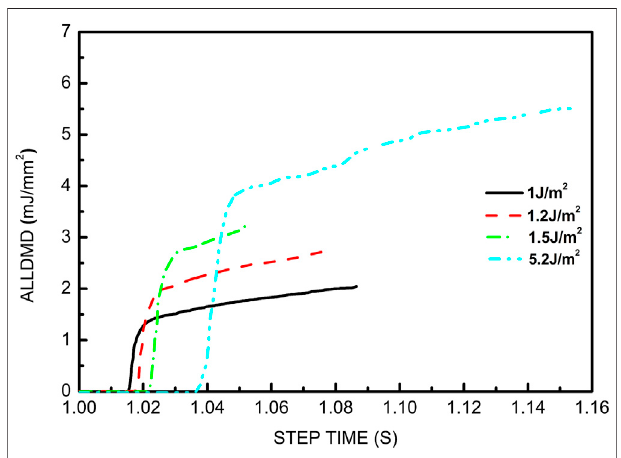
FIGURE11| ALLDMDcurvesfordifferentgrainboundaryfractureenergies.